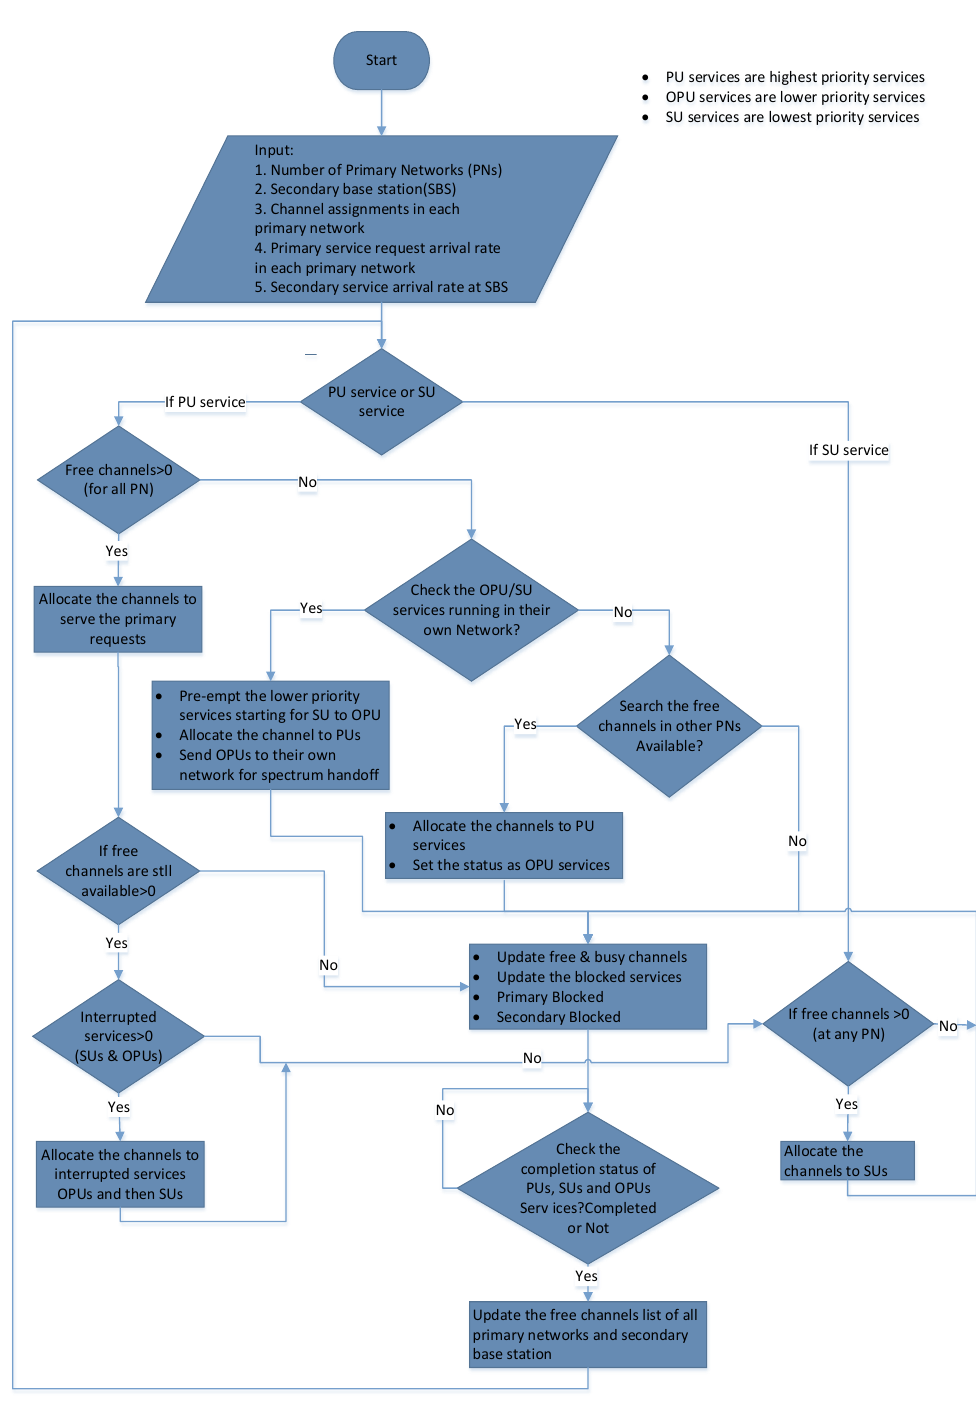
Figure 2. The flow